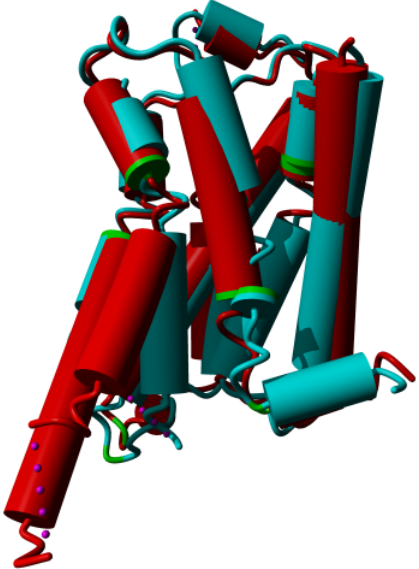
Figure 8. β -2 adrenoceptor in the active state (PDBid = 3sn6 [11]; red) superposed on the inactive state (PDBid = 3ny8 [12]; cyan). The superposition was performed with the WHAT IF superposition module and involved 239 residues that matched with an RMS C α displacement of 1.34 Å. Ligands, sugars, G proteins, etc. are not shown for clarity. Prolines are colored green. The major differences observed are in helices V and VI in the lower left of the figure. In the active form, helix V is much longer and the cytosolic half of helix VI is rotated outwards by about 30 degrees (please note that this involves a rotation of the entire helix, not just the cytosolic half). Further large differences are seen in helix VII (in the centre) and in the corner between helices VII and VIII. The different orientation of helix I (right most helix) in the two structures is most likely caused by crystal packing